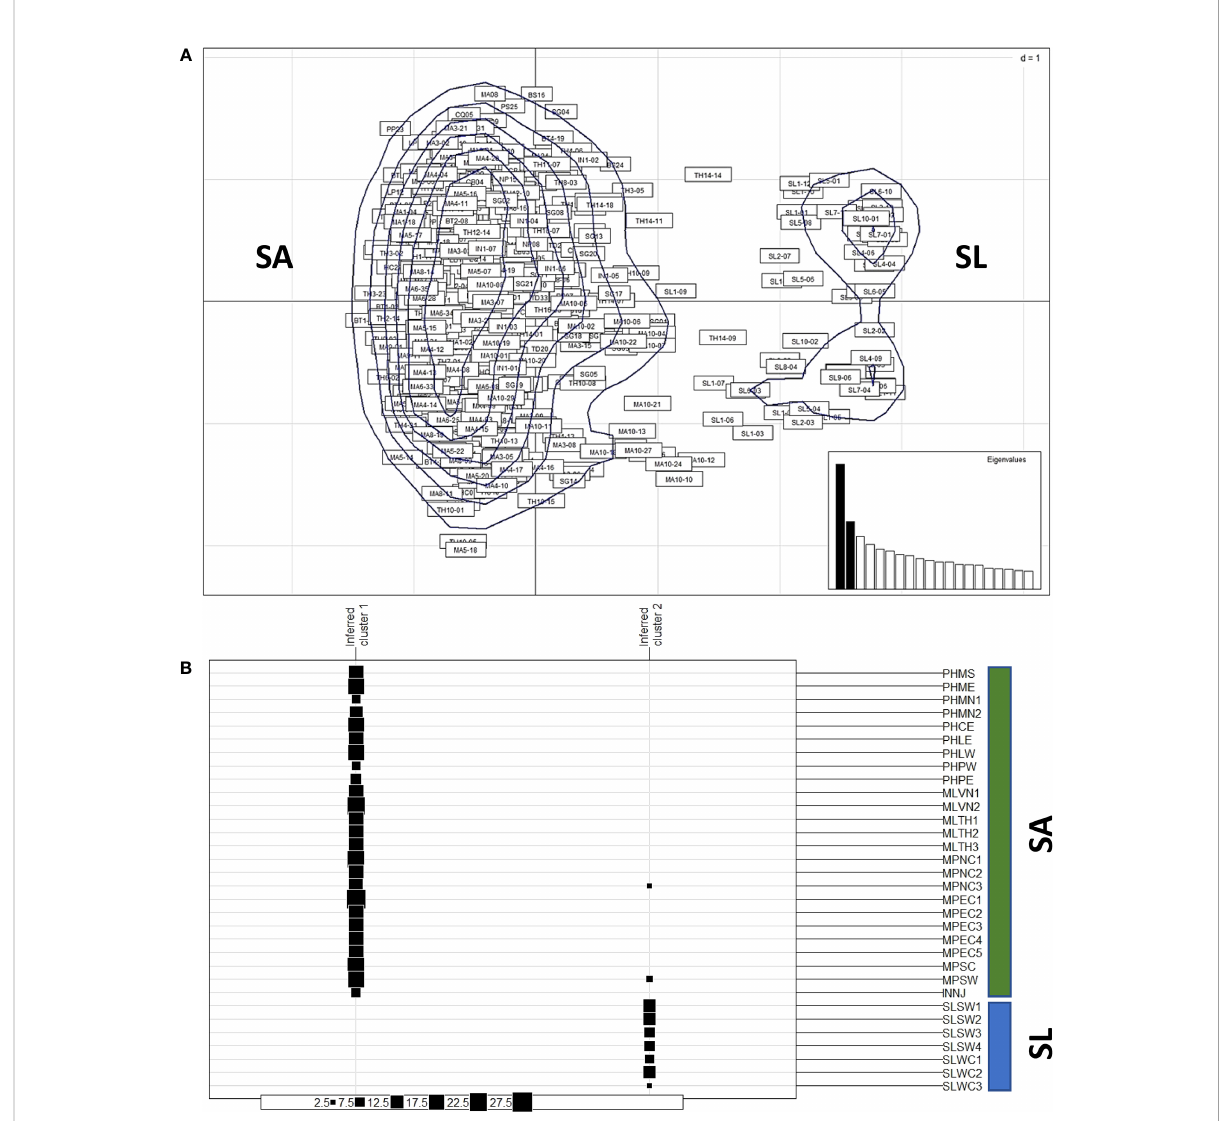
FIGURE 2 Clustering of populations from Southeast Asia (SA) and from Sri Lanka (SL). (A) The principal coordinates analysis (PCoA) of nipa samples from 32 populations in IWP showing the kernel density estimate of individuals, which can be clustered into two major groups: one larger group includes samples from SA and one smaller cluster includes samples from SL. (B) Discriminant analysis of principal components (DAPC) suggests two clusters (K = 2) of nipa populations in IWP according to inferred clusters. The group size of each location is indicated by solid boxes (from 2.5 to 27.5). The symbols of locations are according to Table